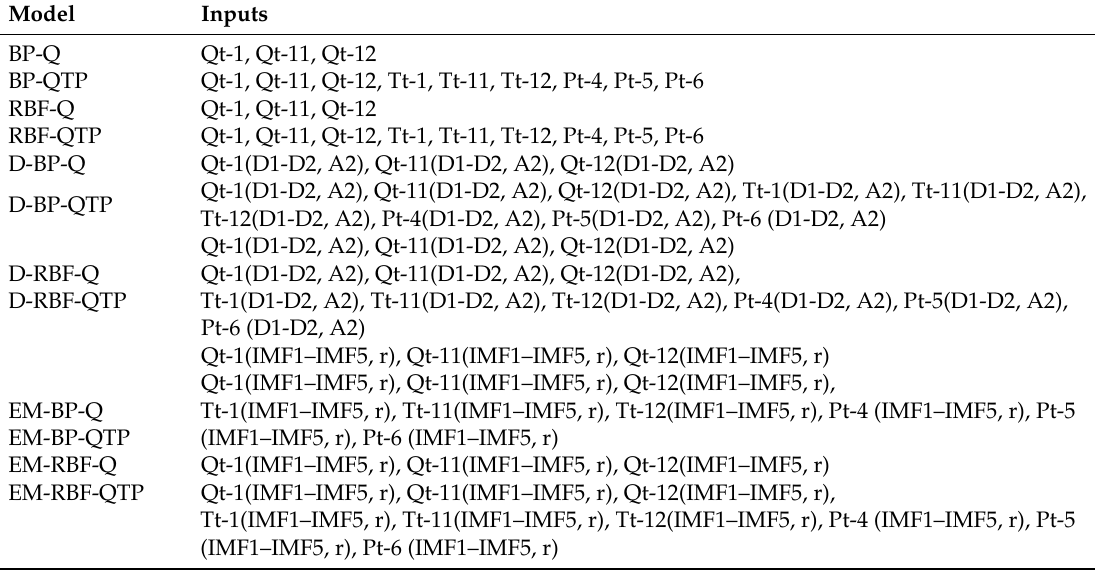
Table 5. Models and their corresponding inputs for zone